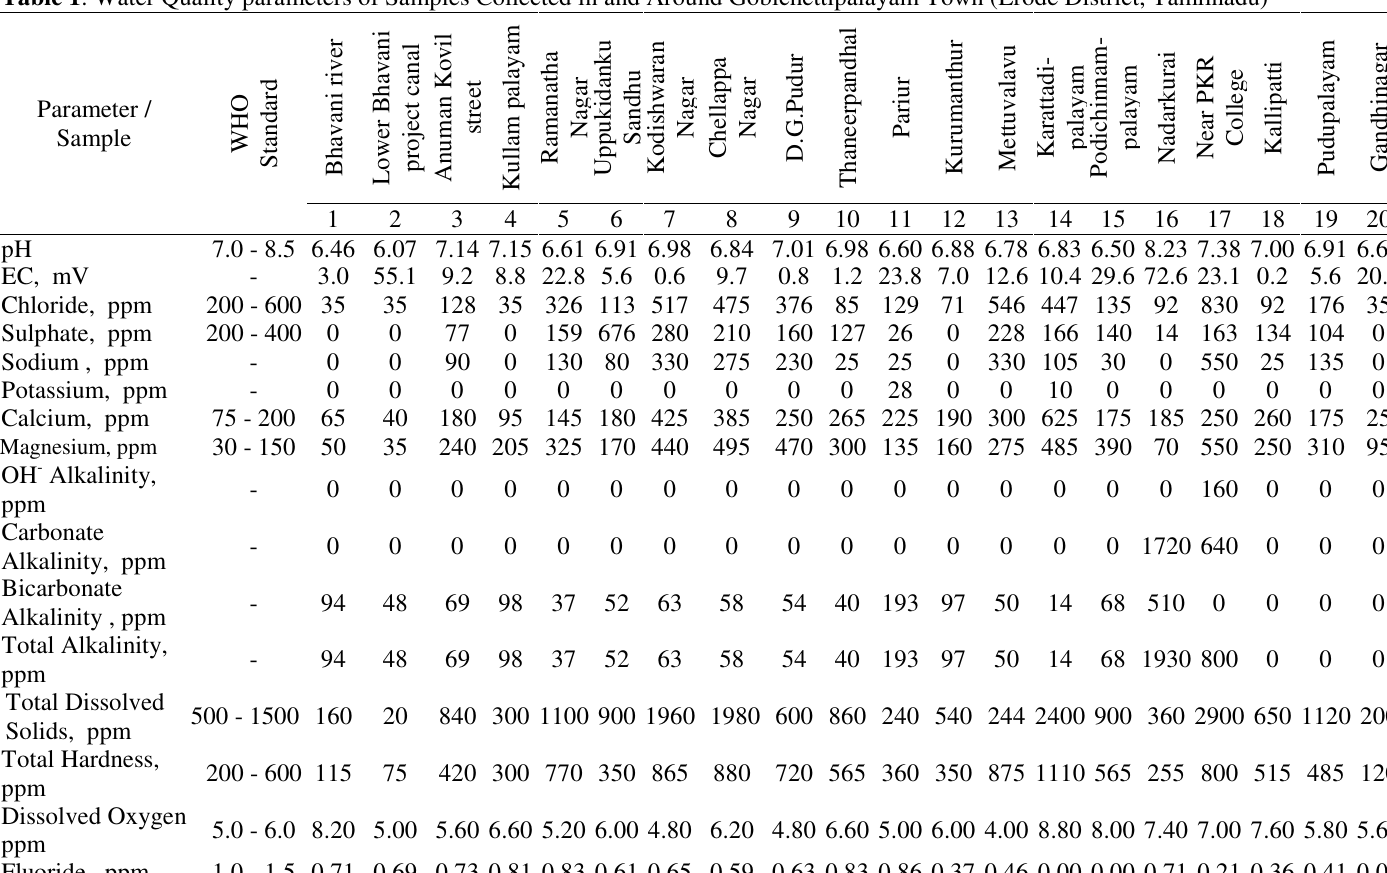
Table 1 . Water Quality parameters of Samples Collected in and Around Gobichettipalayam Town (Erode District, Tamilnadu)